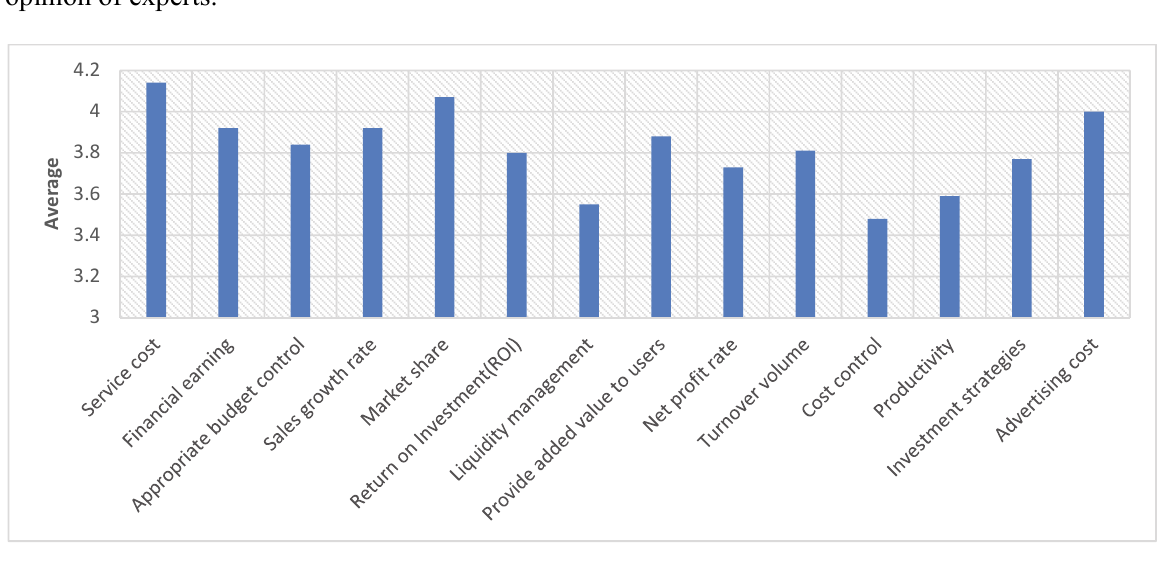
Fig. 6. Indicators of financial construct and their average